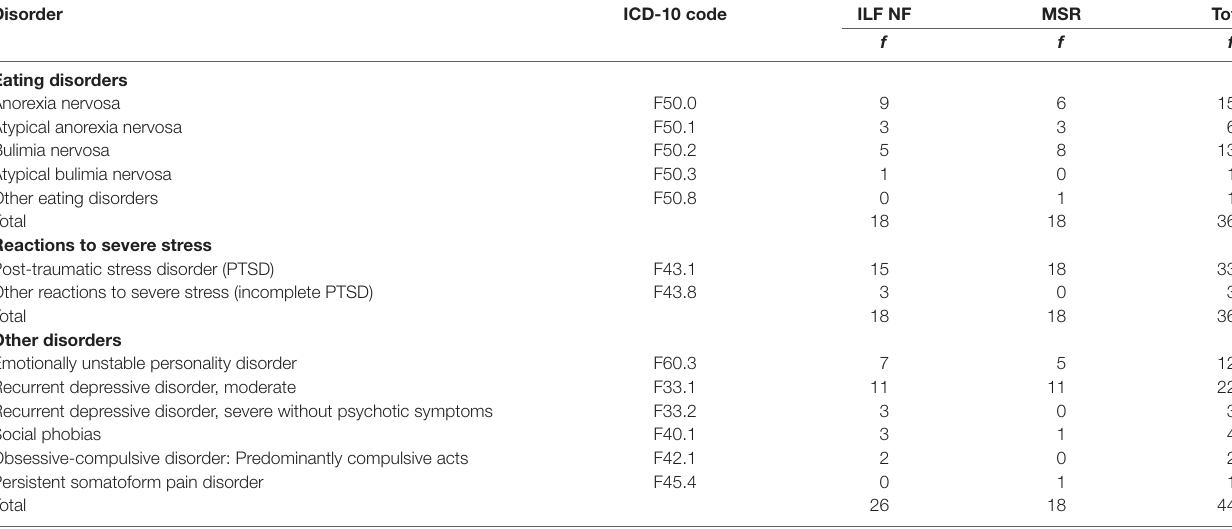
TABLE 2 | Mental and behavioral disorders in the sample.